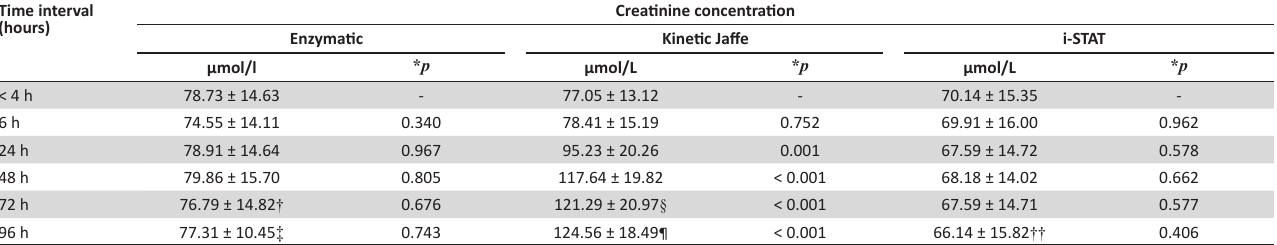
(Table 1). The mean creatinine concentrations analysed using the kinetic Jaffe method were significantly higher than baseline when blood samples were processed after 6 h: p ≤ 0.001 for all comparisons. Creatinine concentrations did